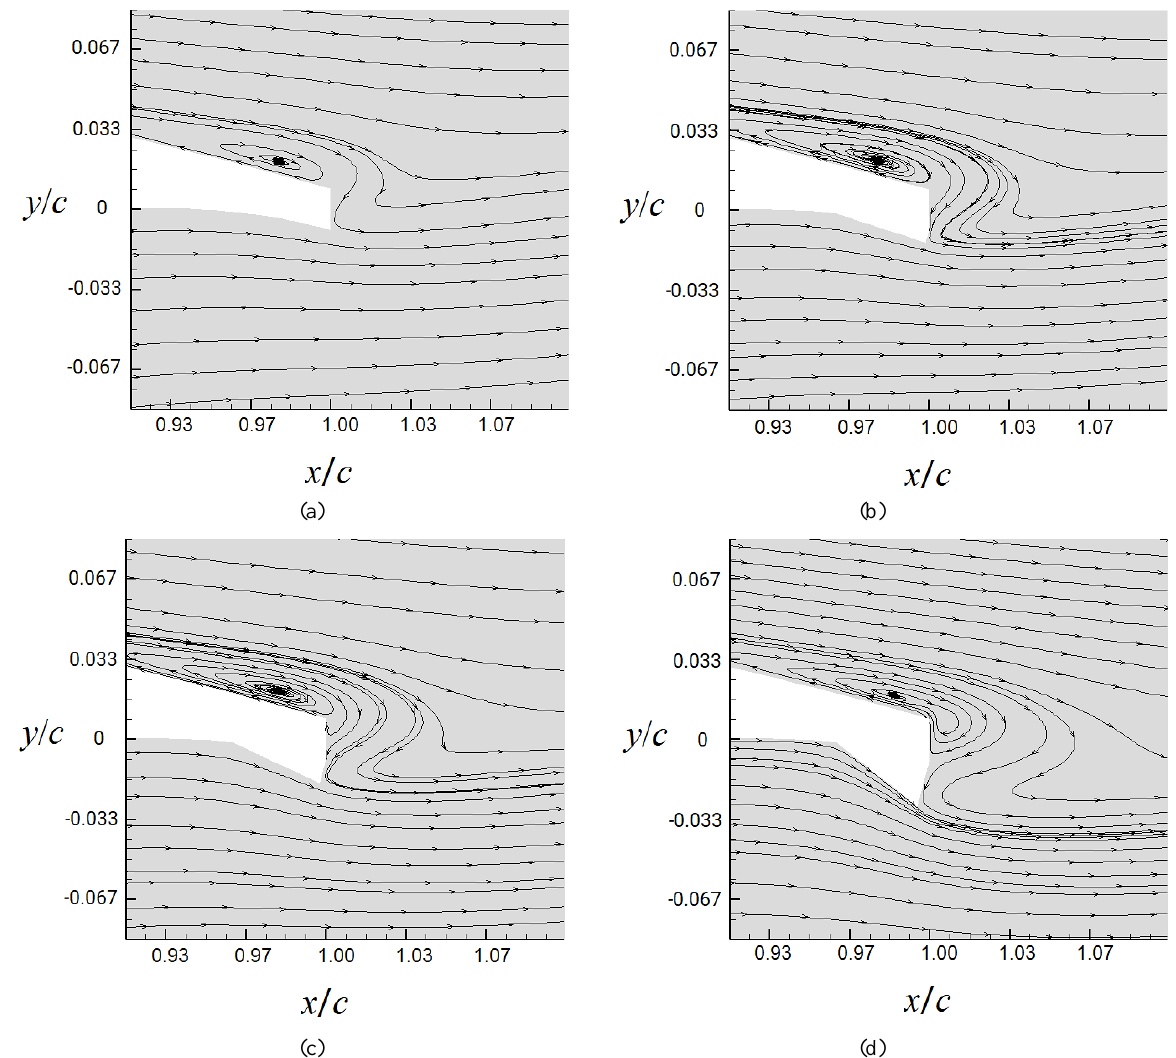
Figure 15. Flow structure at the middle plane for the airfoil equipped with (a) VGs and for the airfoil equipped with VGs in the presence of trailing-edge wedge at heights of (b) H / c =0.5%, (c) 1% and (d)